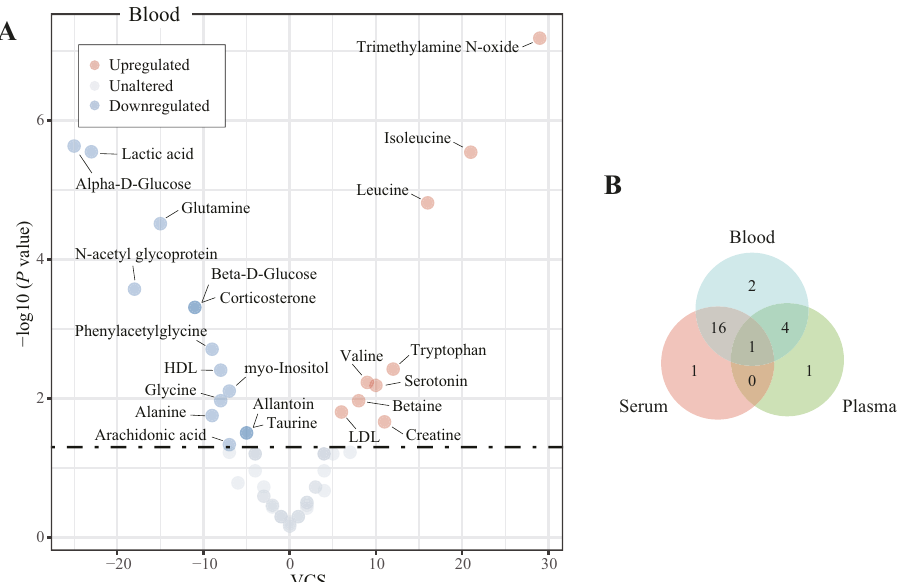
Fig. 2 Effects of pharmacological treatment on metabolite alterations in the blood of depression models. A Volcano plot for consistently upregulated (red) and downregulated (blue) metabolites across studies. The vote-counting statistic (VCS) is presented on the x -axis and the − log10 ( p value) is presented on the y -axis. B Venn plot for shared dysregulated metabolites between blood, serum, and plasma. HDL high- density lipoprotein, LDL low-density